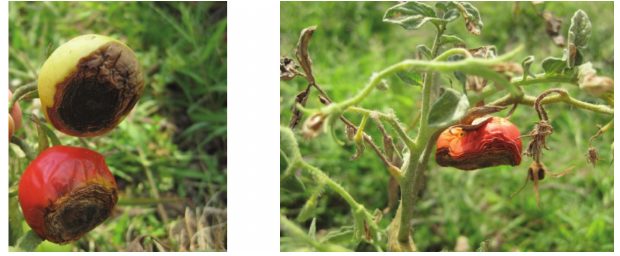
Fig. (3 and 4): Tomato fruits infected with Rhizoctonia soil rot